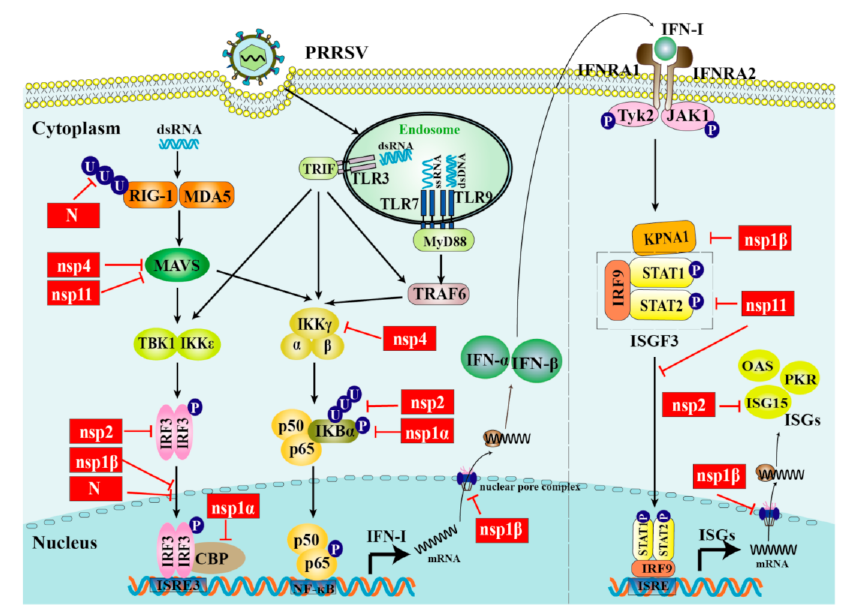
Figure 1. The modulation of the type I interferon (IFN) signal pathway by porcine reproductive and respiratory syndrome virus (PRRSV) proteins. RIG-I and MDA5 detect dsRNA and initiate the adaptor protein MAVS to trigger IRF3 and NF- κ B activations. TLR3, located at endosomes, senses dsRNA and transduces signals through TRIF, and TLR7 senses ssRNA and transduces signals through MyD88, leading to the activation of IRFs and NF- κ B. After transferring to the nucleus, IRFs and NF- κ B will transactivate the promoters to induce type I IFN expressions. IFN-I binds to IFNAR1 and IFNAR2 heterodimers, which transduce signals through recruiting JAK1 and TYK2, and result in STAT1 and STAT2 activation and binding to IRF9, constituting the ISGF3 complex. The complex translocates into the nucleus and promotes ISGs gene expression. PRRSV proteins can hijack multiple steps in type I IFN signal pathways. PRRSV nsp1 α inhibits the association between IRF3 and CREB binding protein (CBP), enhances CBP degradation, and interferes with I κ B degradation. PRRSV nsp1 β inhibits the phosphorylation and nuclear translocation of IRF3, and degrades KPNA1 to block ISGF3 nuclear translocation. PRRSV nsp2 inhibits IRF3 phosphorylation, interferes with I κ B polyubiquitination, prevents I κ B degradation, and inhibits the ISG15 pathway. PRRSV nsp4 cleaves MAVS/VISA and IKK γ /NEMO. PRRSV nsp11 degrades MAVS mRNA, induces STAT2 degradation to interfere with the formation of ISGF3, and inhibits nuclear translocation of ISGF3. N protein inhibits IRF3 phosphorylation and nuclear translocation, and interferes with TRIM25-mediated RIG-I ubiquitination. P, phosphate; U,